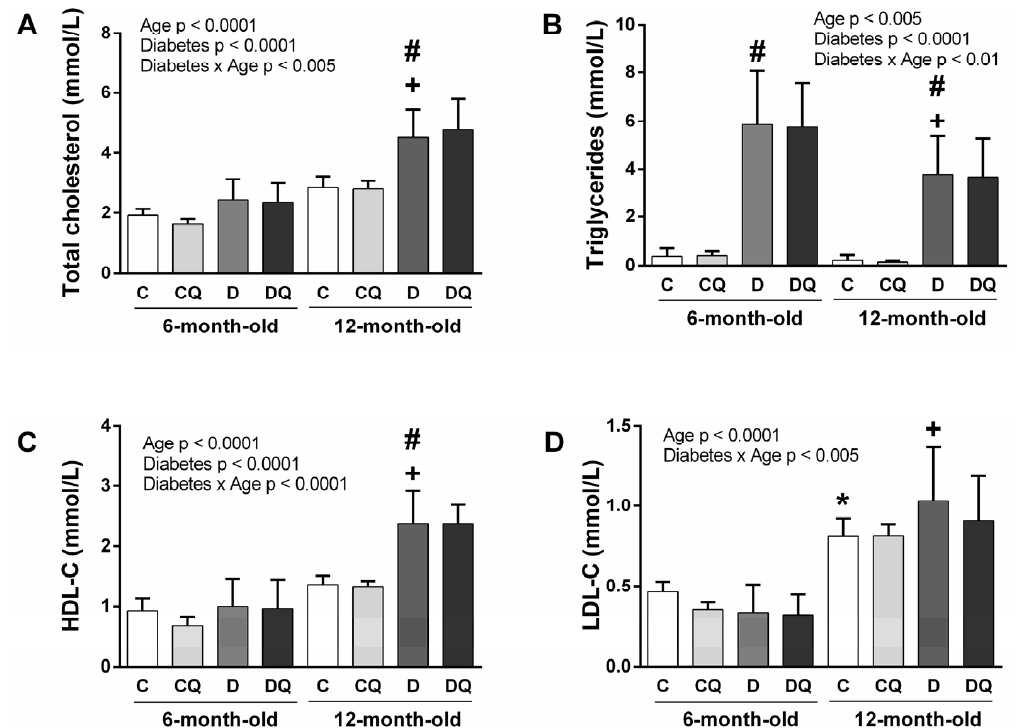
Figure 2. Parameters of lipid metabolism. Concentration of total cholesterol ( A ), triglycerides ( B ), HDL-cholesterol ( C ), LDL-cholesterol ( D ). Abbreviations: C—lean control vehicle-treated, CQ—lean control quercetin-treated, D—Zucker diabetic fatty (ZDF) vehicle-treated, DQ—ZDF quercetin-treated. * p < 0.05 versus 6-month-old C group, + p < 0.05 versus 6-month-old D group, # p < 0.05 versus age-matched C group. Data are presented as means ± standard deviations.